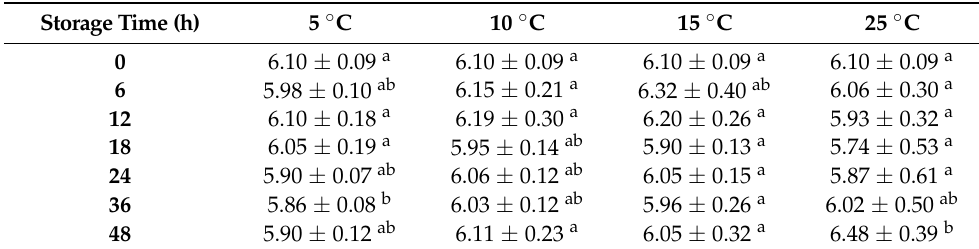
Table 4. pH of cinnamon-marinated meat stored at 5, 10, 15, and 25 ◦ C. Storage Time (h)